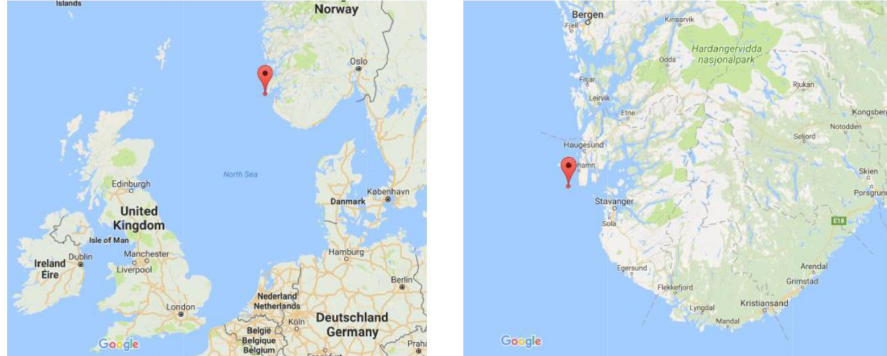
Figure 2. TetraSpar demonstrator project location.